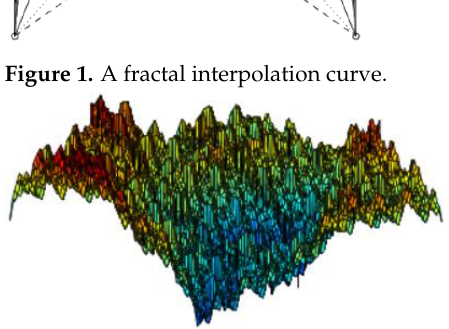
Figure 2. A fractal interpolation surface.